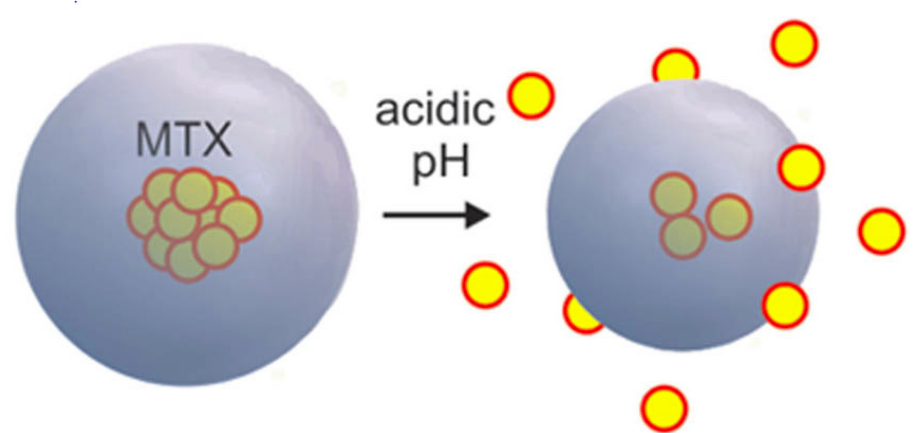
Figure 3. pH-sensitive micelles loaded with methotrexate (MTX) disassemble to release MTX in the presence of an acidic tumor microenvironment. A diblock copolymer of poly(monomethoxy eth- ylene glycol)-b-poly( ε -caprolactone) (mPEG-PCL) was used in the preparation, and the release was triggered by the sensitivity of the ester linkages to acidic pH. Reproduced from [60] CC-BY License.